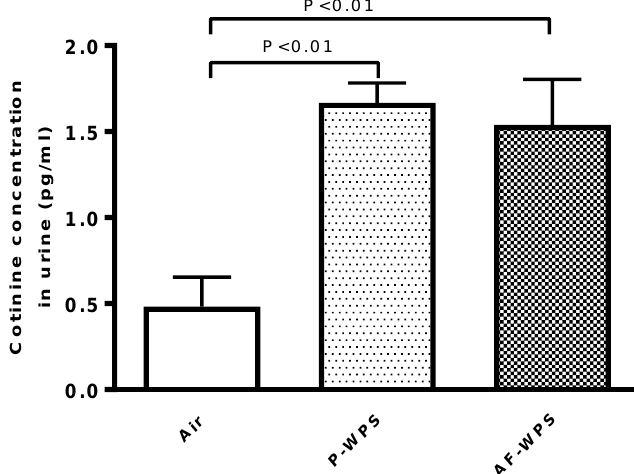
Figure 12. Effects of plain water-pipe smoke (P-WPS) or apple-flavoured (AF)-WPS on cotinine concentrations in urine. Cotinine concentrations measured in urine at the end of 1 mo exposure period to either air or P-WPS or AF-WPS. Data are mean ± SEM (n = 5); one-way ANOVA followed by Holm–Sidak’s multiple comparison test.